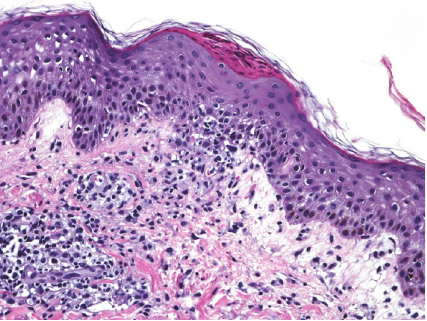
Figure 2: Focal lichenoid inflammation at the dermal-epidermal junction, mild spongiosis, and focal areas of